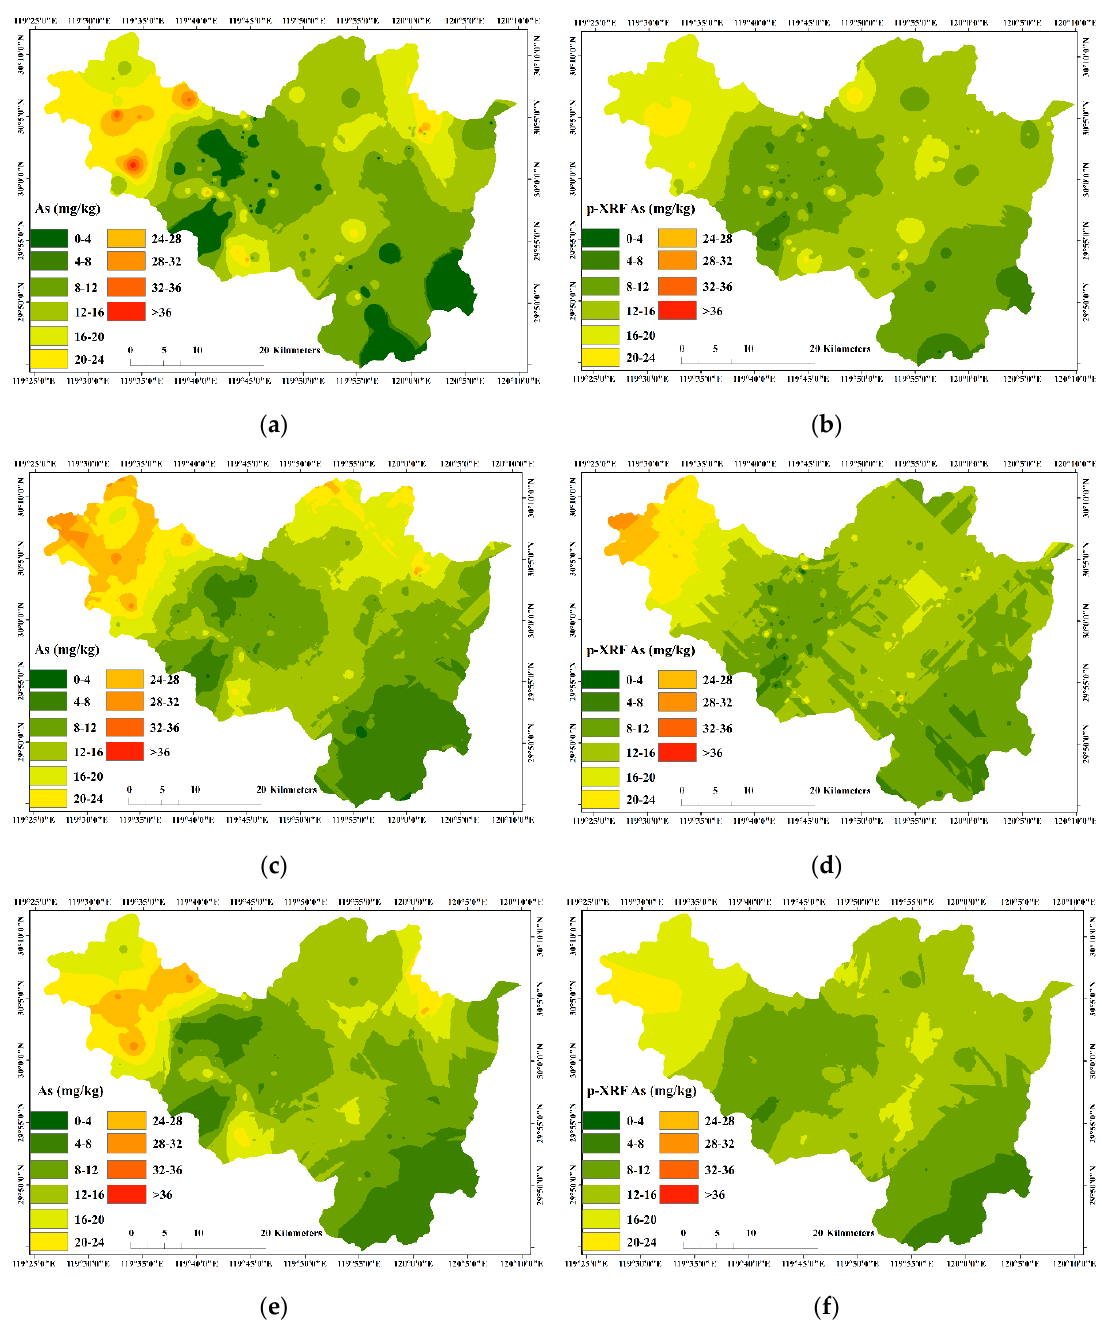
Figure 4. Maps of As content measured by LC-ICP-MS (left column) and p-XRF (right column) using IDW ( a , b ), OK ( c , d ), and EBK ( e , f ) geostatistical methods.